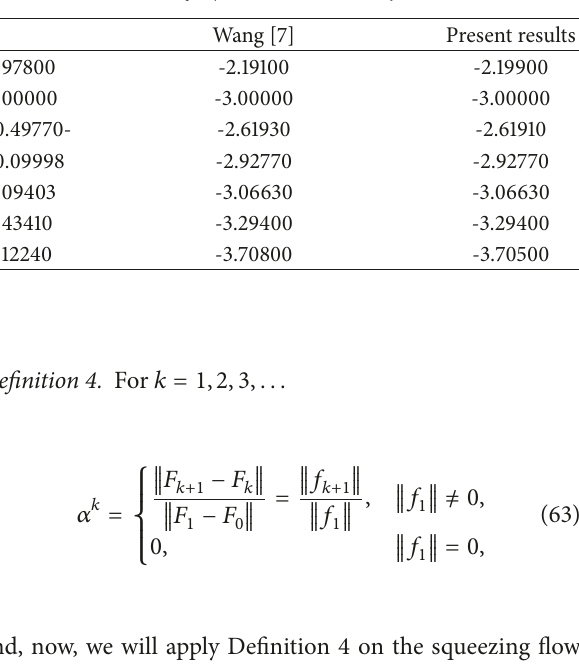
Table 1: Comparison between analytical-approximate solution and numerical solution for 𝑓(𝜂) when 𝑀 = 0 and 𝛾 󳨀→ ∞